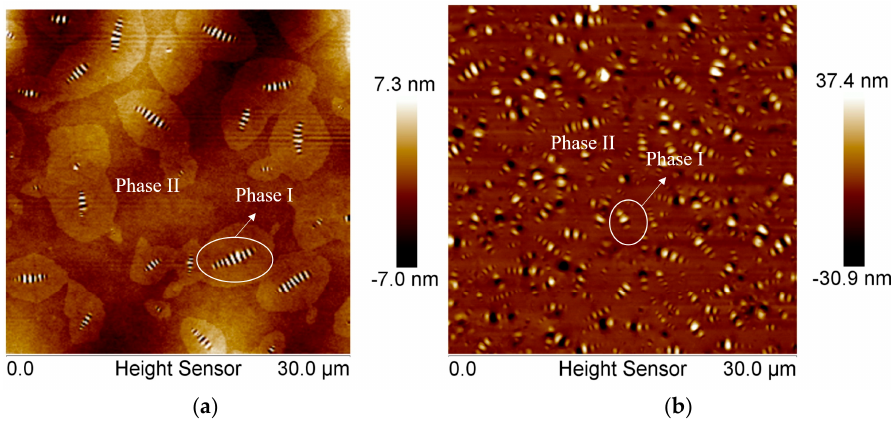
Figure 3. The nano-morphology of bitumen tested by AFM: ( a ) Type α ; and ( b ) Type β .